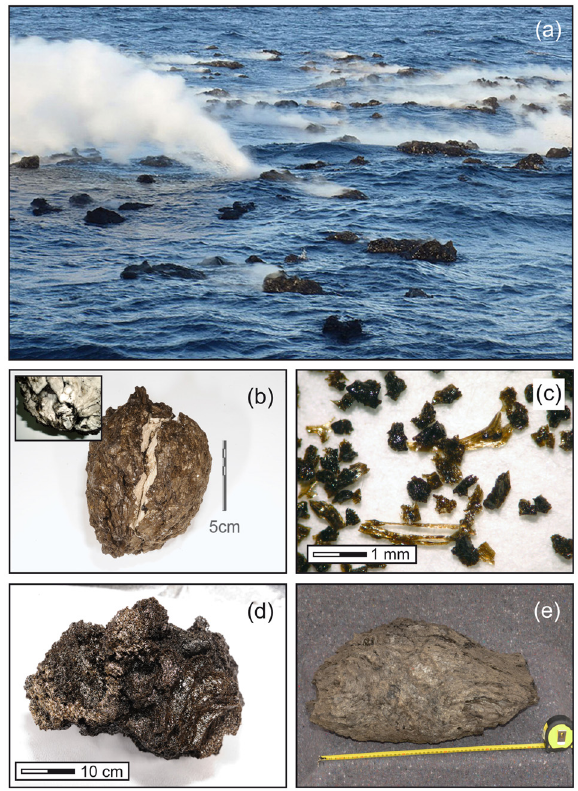
Figure 1. Map of El Hierro Island with highlighted the main mor- phological features. Green shaded zones: rift lines. Red dashed lines: Landslides scars. Stars indicate the most recent eruptions on the is- land; yellow star: Las Chamuscadas, red star: Tanganasoga and blue star: Lomo Negro. White cross: location of the vent of the 2011-2012 eruption. In map are also highlighted the position of instruments of multiparametric monitoring network that was deployed on the island by Instituto Geográfico Nacional: triangles - Seismic stations; circles - permanent GPS stations; squares - permanent gravimetric station.